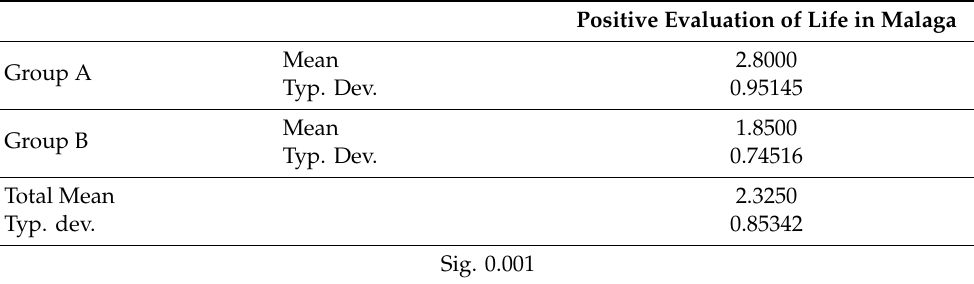
Table 10. E ff ect of the learning group on the subjective evaluation of life in